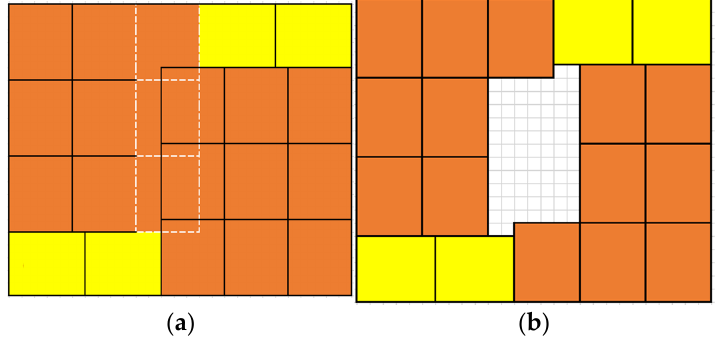
Figure 9. Vertical multi-object overlap. ( a ) Before removal. ( b ) After removal.